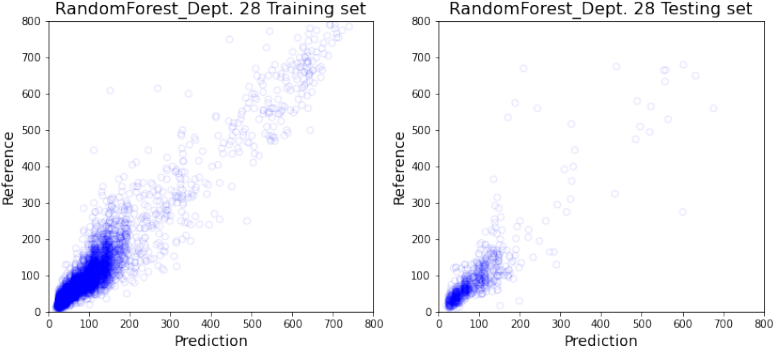
Figure A8. Model Performance of RandomForest on Dept.28. The visualization of training and testing data for department specific model on department 28 with Random Forest.